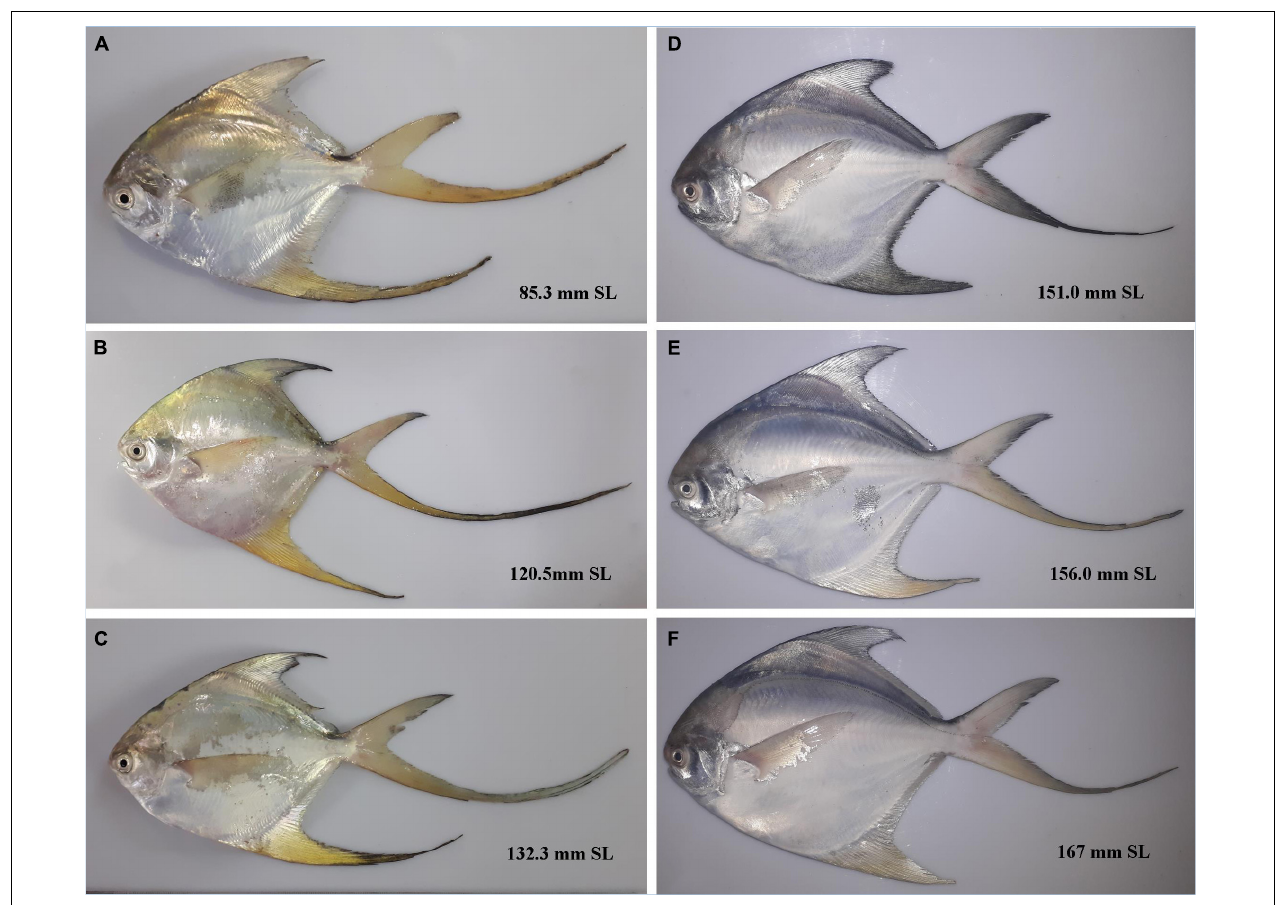
FIGURE 7 | Pampus griseus . (A–C) juvenile and (D–F) adult